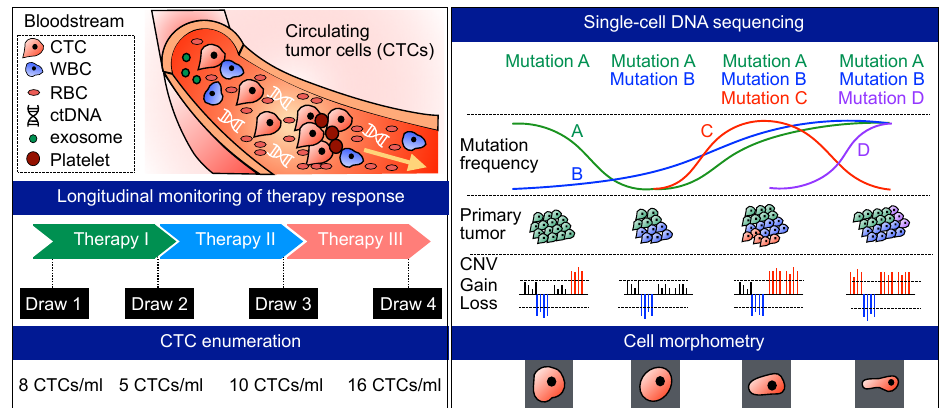
Figure 3. scCTC DNA sequencing for longitudinal monitoring of therapy